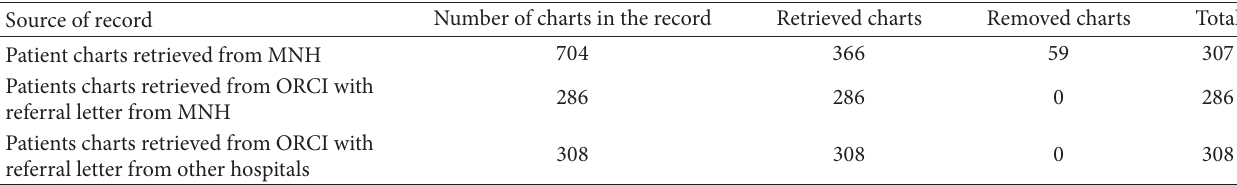
Table 1: Number and source of patient